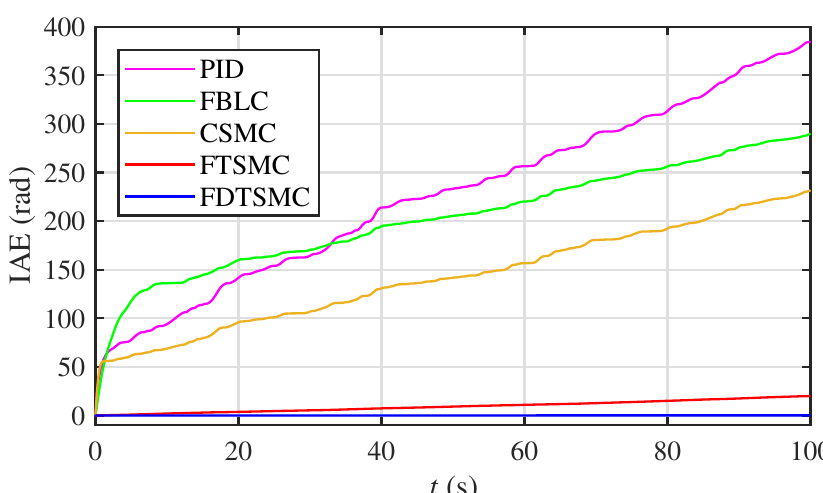
Figure 17. Integral absolute